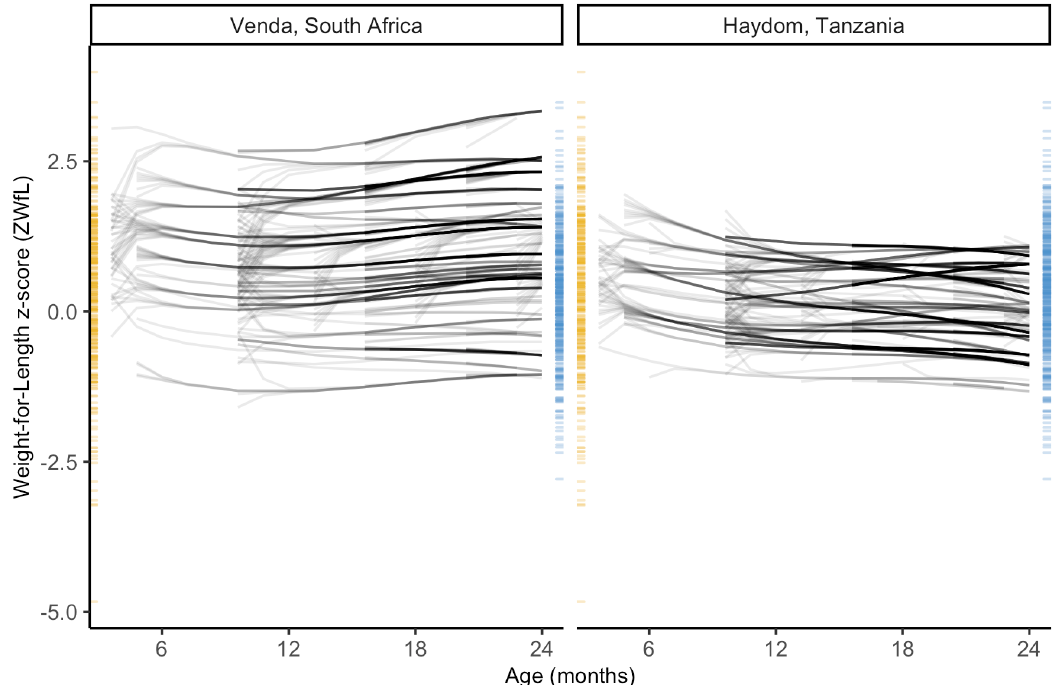
Figure 4. Predicted future weight-for-length trajectories from a grid of starting points using an SDE model. Yellow ticks indicate the observed weight-for-length at 0 months; blue ticks indicate the observed weight-for-length at 24 months. The best-fitting predictions are shown in red and 10-fold cross validation in grey. The distributions of observed weight-for-length at both zero and 24 months in each site is shown to the right of the respective plot. The predictions appear to cluster together into a smaller set of “paths”, which also differ between